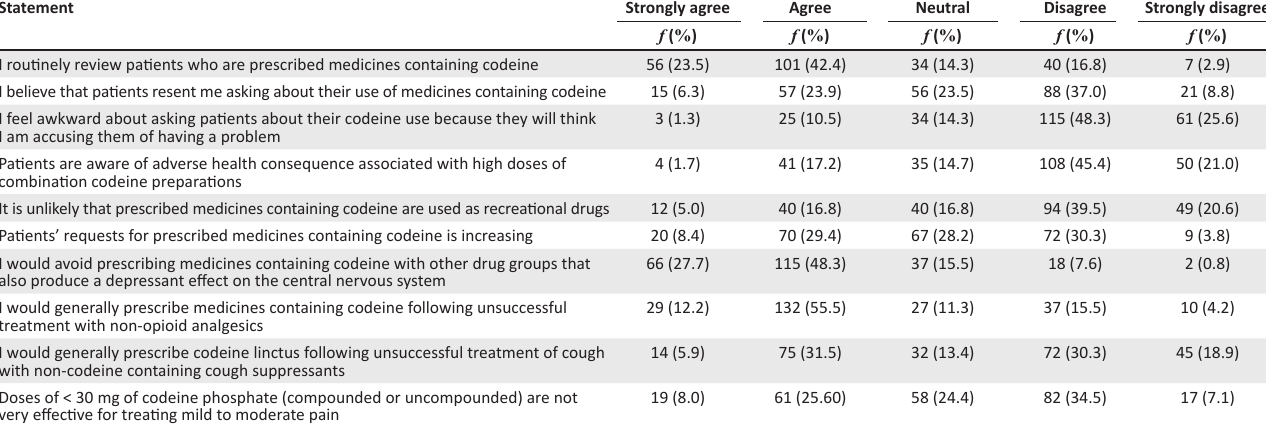
TABLE 2: Level of agreement, disagreement and neutral responses with each of the statements related to codeine use, including prescribed codeine.